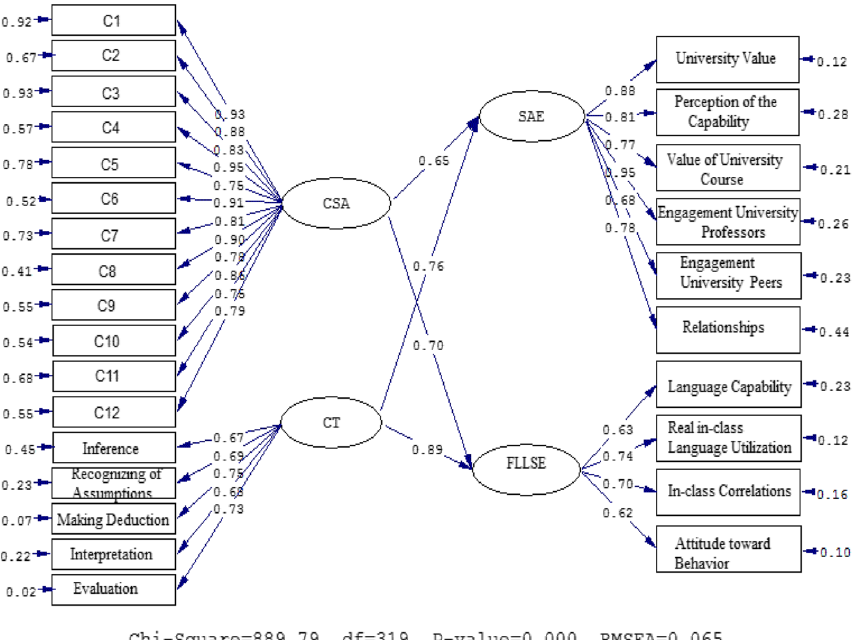
Fig. 2 Schematic representation of path coefficient values for the relationships between CSA, CT, FLLSE, and SAE (model